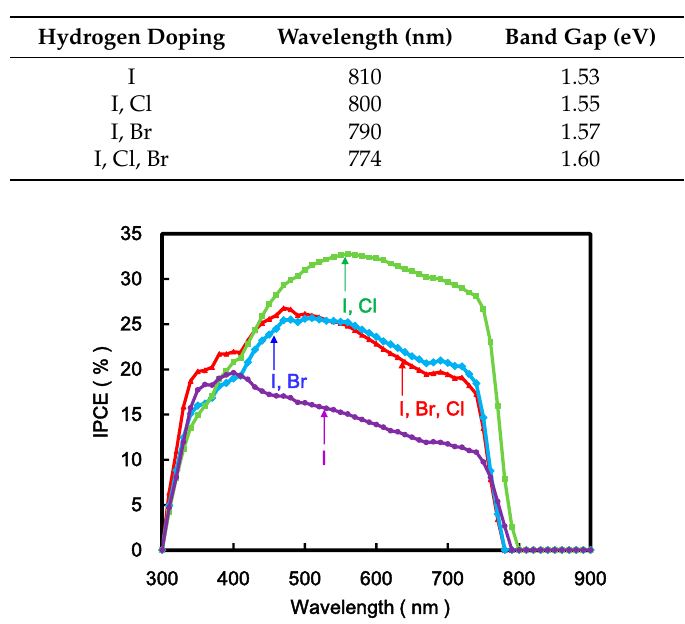
Figure 4. Incident photon to current conversion efficiencies (IPCEs) of FTO/TiO 2 /CH 3 NH 3 PbI 3 ´ x ´ y Br x Cl y /spiro-OMeTAD/Au photovoltaic cells.